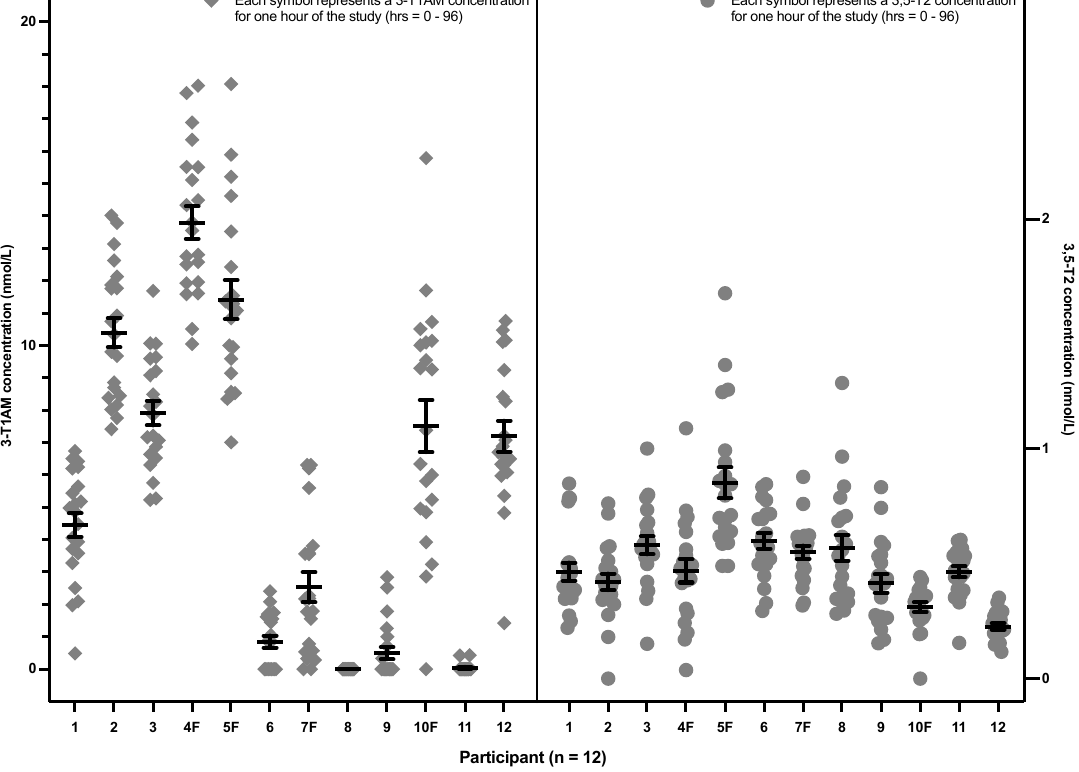
Figure 3. 3,5-T2 and 3-T1AM concentrations from the hourly sampling after a single 50 mcg dose of LT3 grouped by the 12 individual healthy volunteers (The lower limit of detection is 0.2 nmol/L for 3,5-T2 and approximately 5 nmol/L for 3-T1AM. 3,5-T2: 3,5-diiodothyronine, 3-T1AM: 3-iodothyro- namine, LT3: liothyronine).